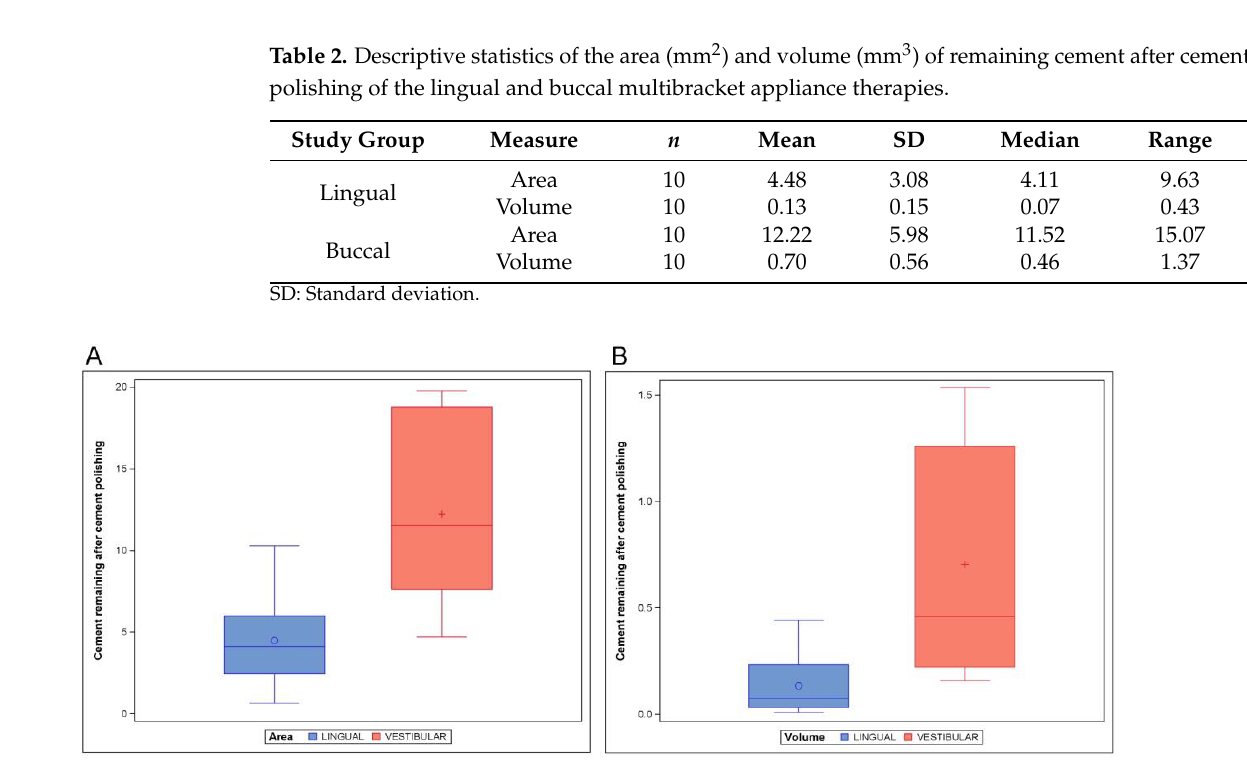
Figure 6. Boxplot of the area ( A ) and volume ( B ) of remaining cement after cement polishing of the lingual and buccal multibracket appliance therapies. The horizontal line in each box represents the respective median value of the study groups. Blue represents lingual multibracket appliance and red represents buccal multibrackets appliance.